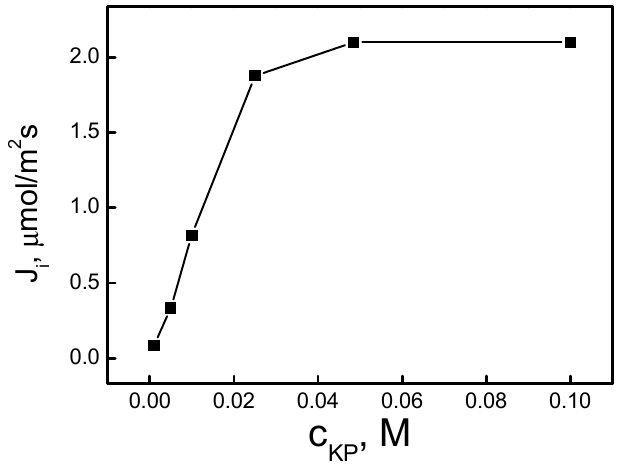
Figure 4. The Ag(I) transport flux vs. the ion carrier concentration in the PIM. Source phase: 1.0 × 10 − 3 M AgNO 3 , pH = 4.0; membrane: 25 mg CTA; 2.0 cm 3 o -NPPE / 1.0 g CTA; receiving phase: 0.10 M Na 2 S 2 O 3 .